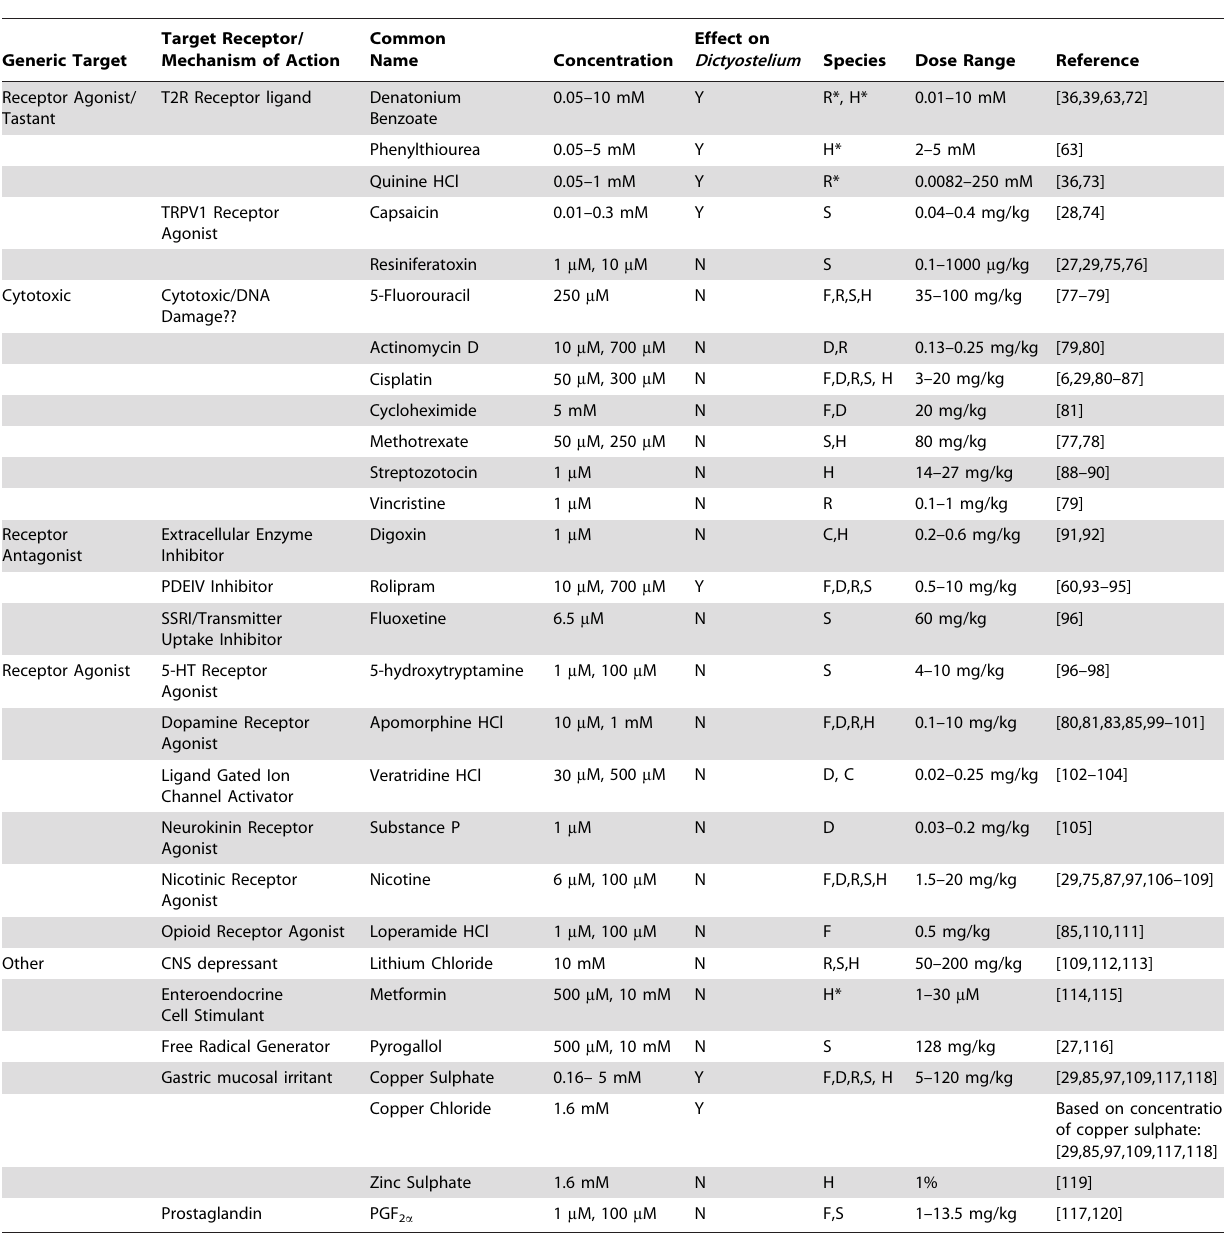
Table 1. Emetic or taste aversive compounds assessed for effects on Dictyostelium behaviour during chemotaxis.